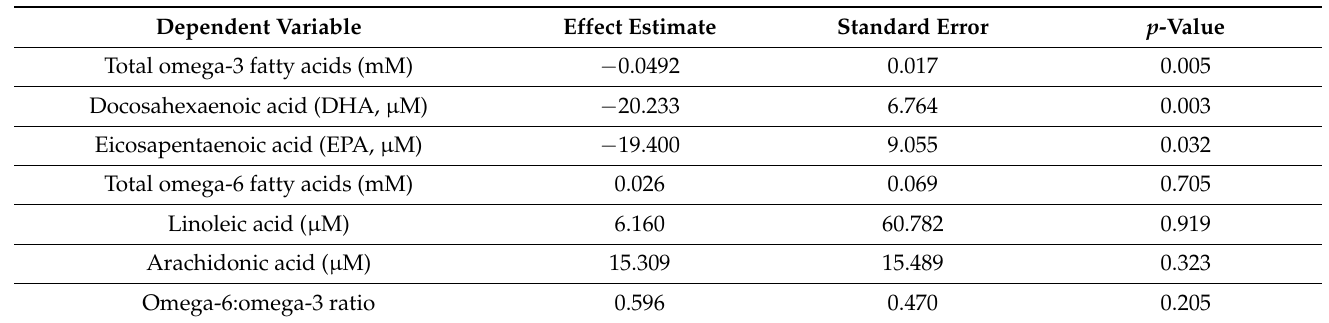
Table 3. Changes in serum fatty acid concentrations as a function of baseline nutritional status ( n = 80). Models are adjusted for supplement group.